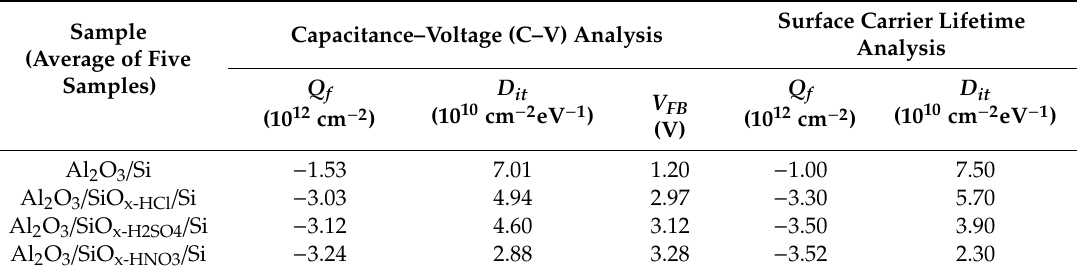
Table 2. Results of capacitance–voltage (C–V) and surface carrier lifetime